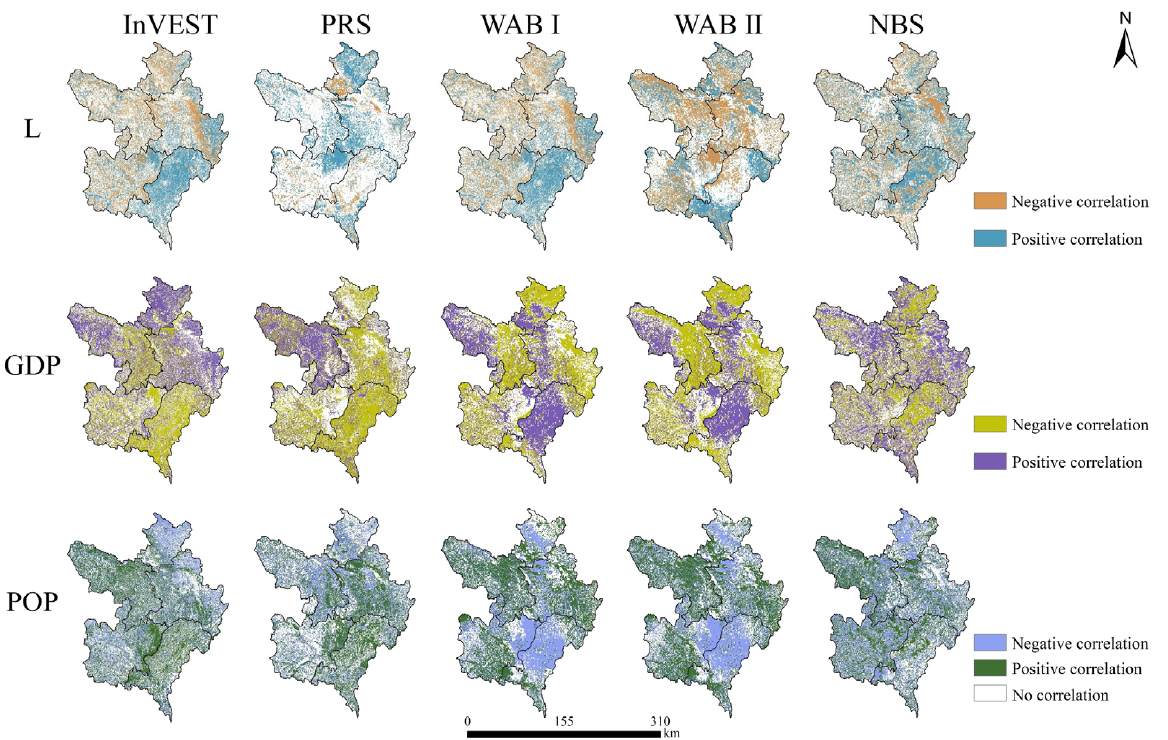
Figure 9. Distribution of partial correlation between socioeconomic factors and WR service by five models ( p < 0.05). L: land use intensity, GDP: gross domestic product, POP: population density.